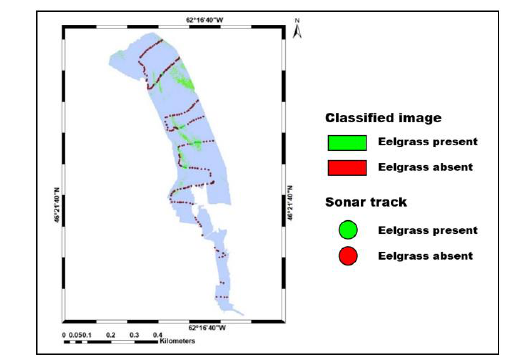
Figure 7. Sonar track overlaid over the UAV classified image for Souris. Table 13. Confusion matrix (in GPS sonar points) and associated accuracies when all the UAV classified images of Richibucto with Random Forests are compared to the sonar data (*)